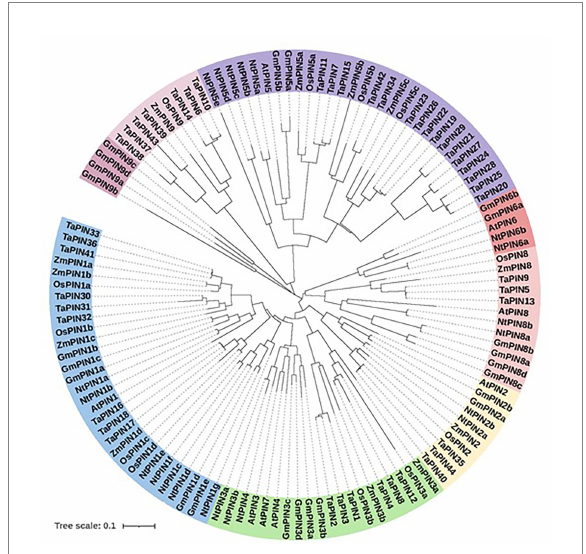
FIGURE 1 Phylogenetic relationships of the PIN proteins from Arabidopsis thaliana, Oryza sativa, Zea mays, Glycine max, Nicotiana tabacum , and Triticum aestivum . The protein sequences were downloaded from the NCBI databases, and from recently published data (Wang et al., 2009, 2015; Forestan et al., 2012; Xie et al., 2017; Kumar et al., 2021). The sequences were aligned with ClustalW, and the phylogenetic tree constructed with the neighbor-joining method implemented MEGA version 11 (Tamura et al.,